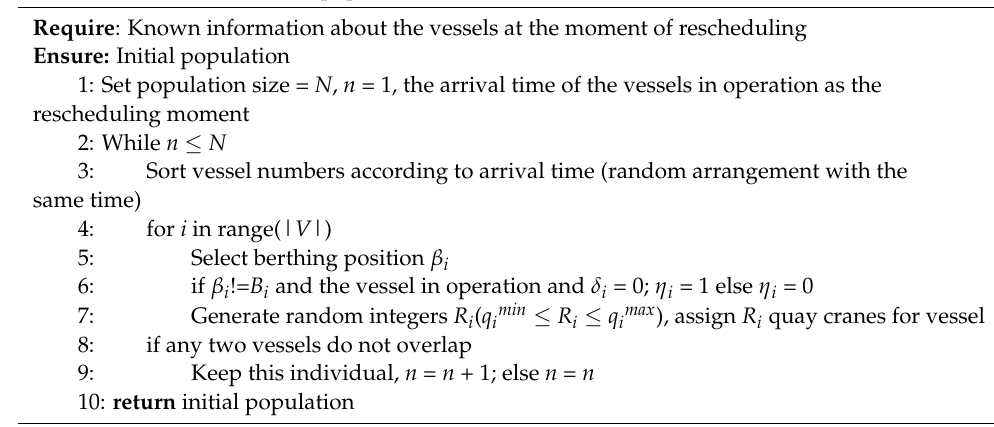
Algorithm 1 Generate initial